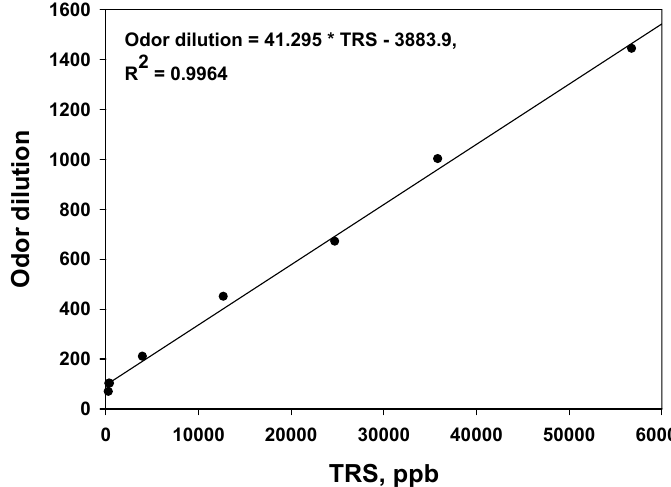
Figure 3. Odor dilution vs. TRS concentration from the sewers in the study